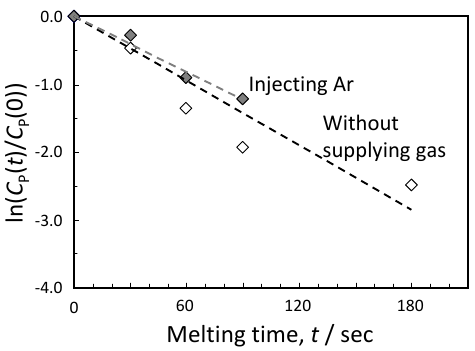
Figure 6. Relation between ln( C P .t/=C P .0// and melting time with and without injection of Ar.